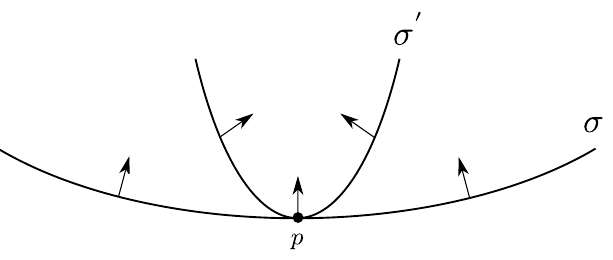
Figure 2 . The surfaces (cid:27) and (cid:27) 0 are shown tangent at the point p . The arrows illustrate the projection of the null orthogonal vectors onto the Cauchy slice. The associated null expansion of (cid:27) 0 lowerbounds that of (cid:27)